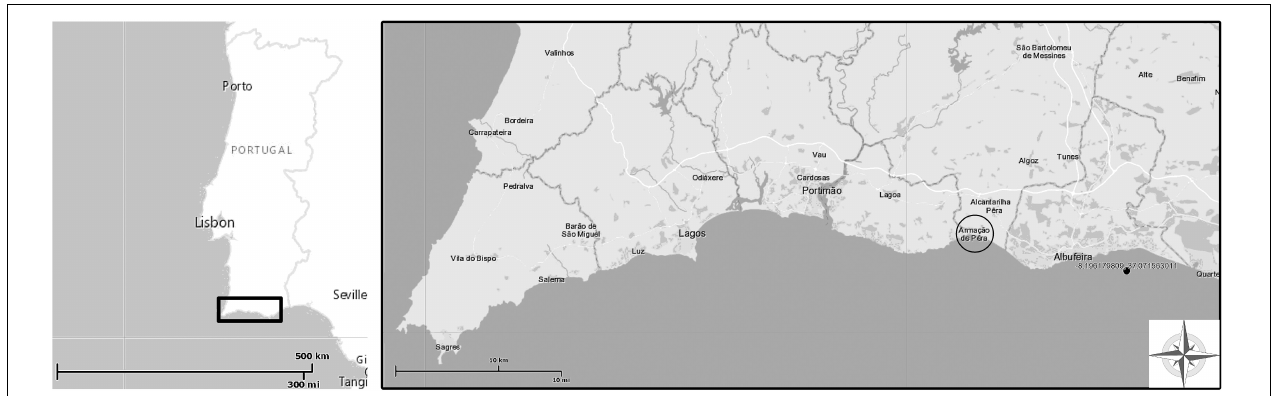
FIGURE 1 | Study site location (SW Iberian Peninsula) in Armação de Pêra Bay, southern Portugal. The maërl bed (20- to 23-m depth) is located 4.7 nautical miles offshore (black dot). Figure modified from source: http://geoportal.lneg.pt/.